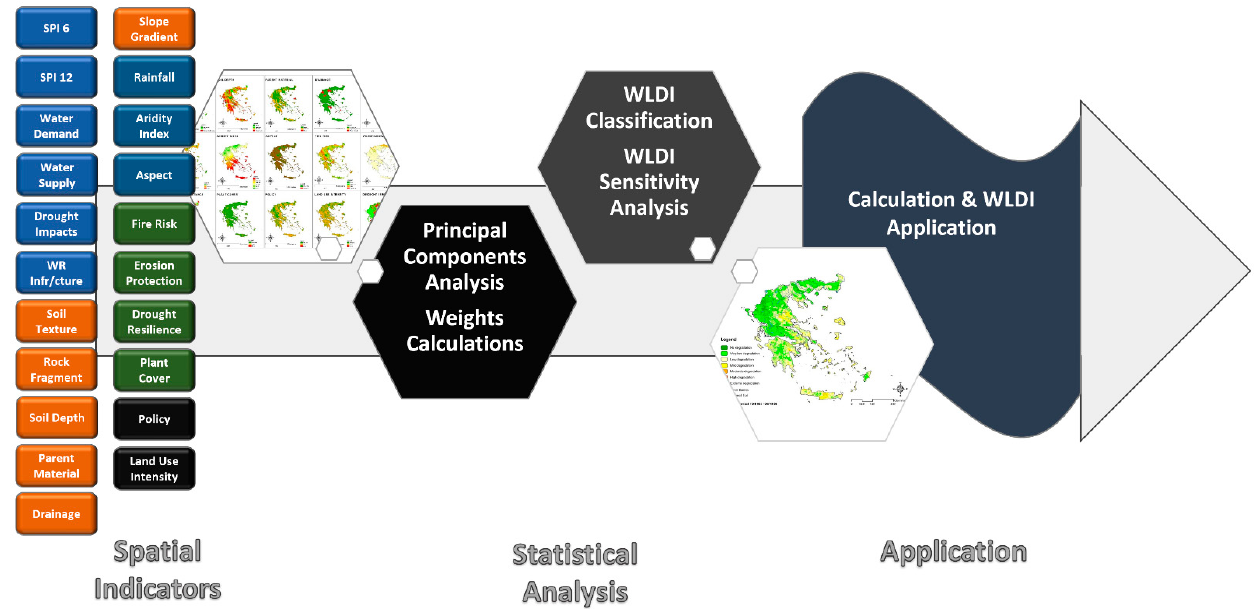
Figure 3. A conceptual model of the proposed methodology.